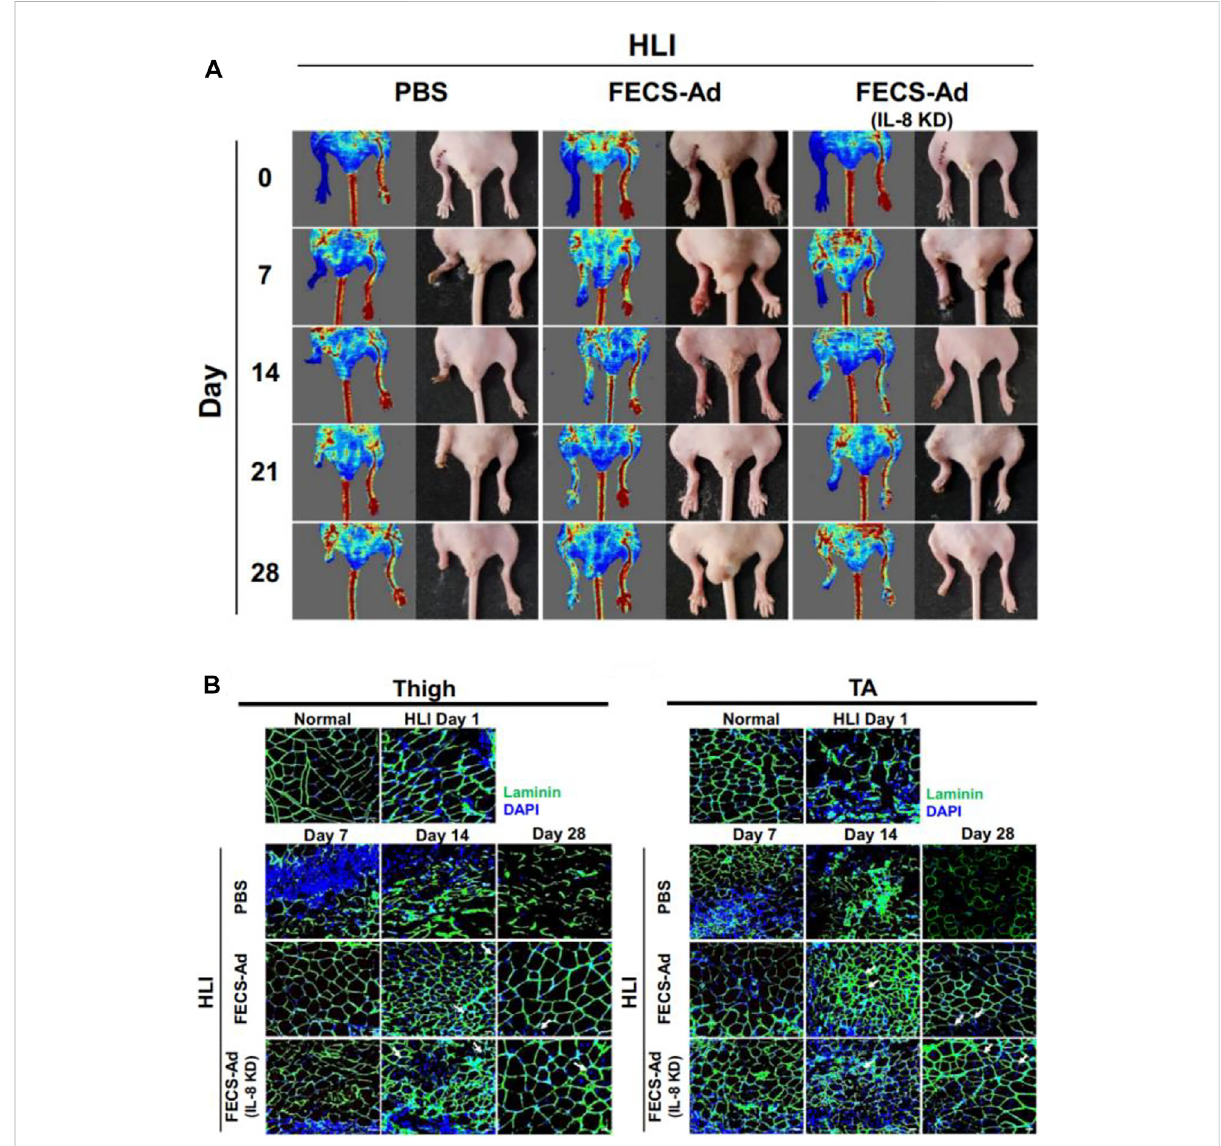
FIGURE 13 Schematicdiagramsofspheroidstoimprovebloodperfusion. (A) RepresentativeimagesofLDPIandhindlimbmorphology.FECS-Adtreatment resultedinthebestrecoveryofblood fl owanditreducedlimbloss. (B) LamininstainingofthethighandTAmusclesshowedthatFECS-Adpromotes muscle fi ber regeneration and restores muscle structure. Scale bar = 20 μ m. Figure adapted with permission from ref. (Choi et al.,